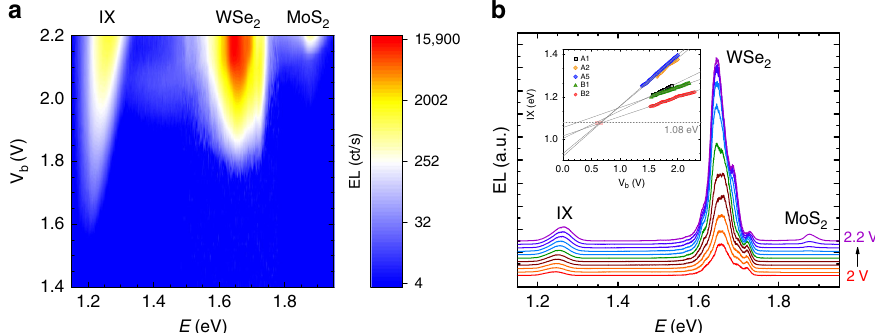
Fig. 2 Interlayer excitons. a False color contour plot of the EL spectra as a function of bias voltage for sample B1 without monolayer hBN spacer. b EL spectra for biases in the range of V b = 2.0 – 2.2 V extracted from ( a ). The spectra are vertically shifted for clarity. The inset in panel ( b ) shows the peak position of the IX as a function of bias for fi ve different samples and linear fi ts to the dependencies. The gray dashed line marks the energy of 1.08 eV, which is an estimation for the energy of a presumptive IX without electrically injected carriers. We obtain this value by using threshold voltages of ~0.6 – 0.7 V (red shaded area) for measurable carrier injection extracted from photoluminescence and re fl ectance contrast measurements